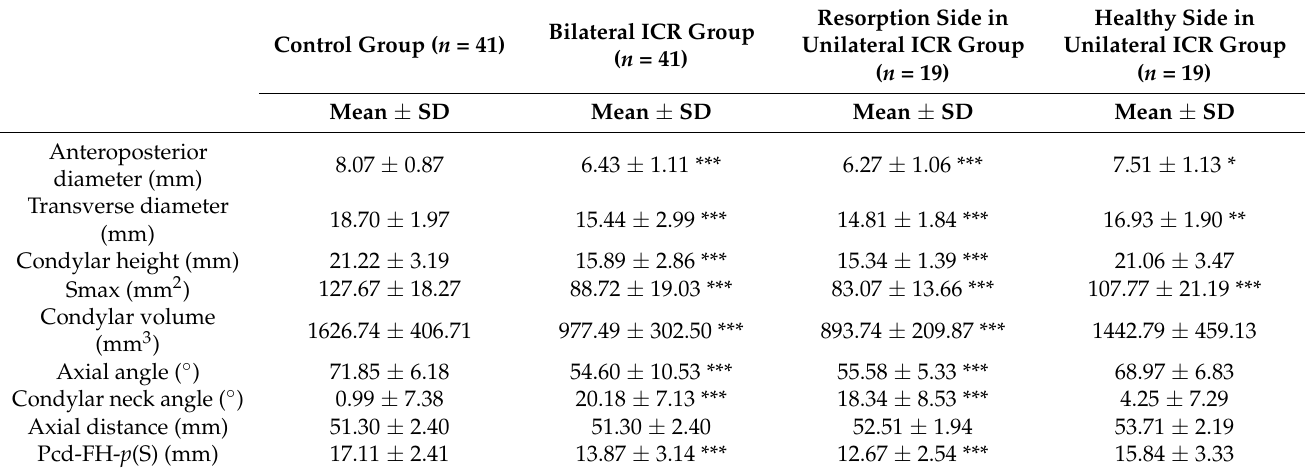
Table 4. Measurements of condylar size, morphology and position in ICR group and control